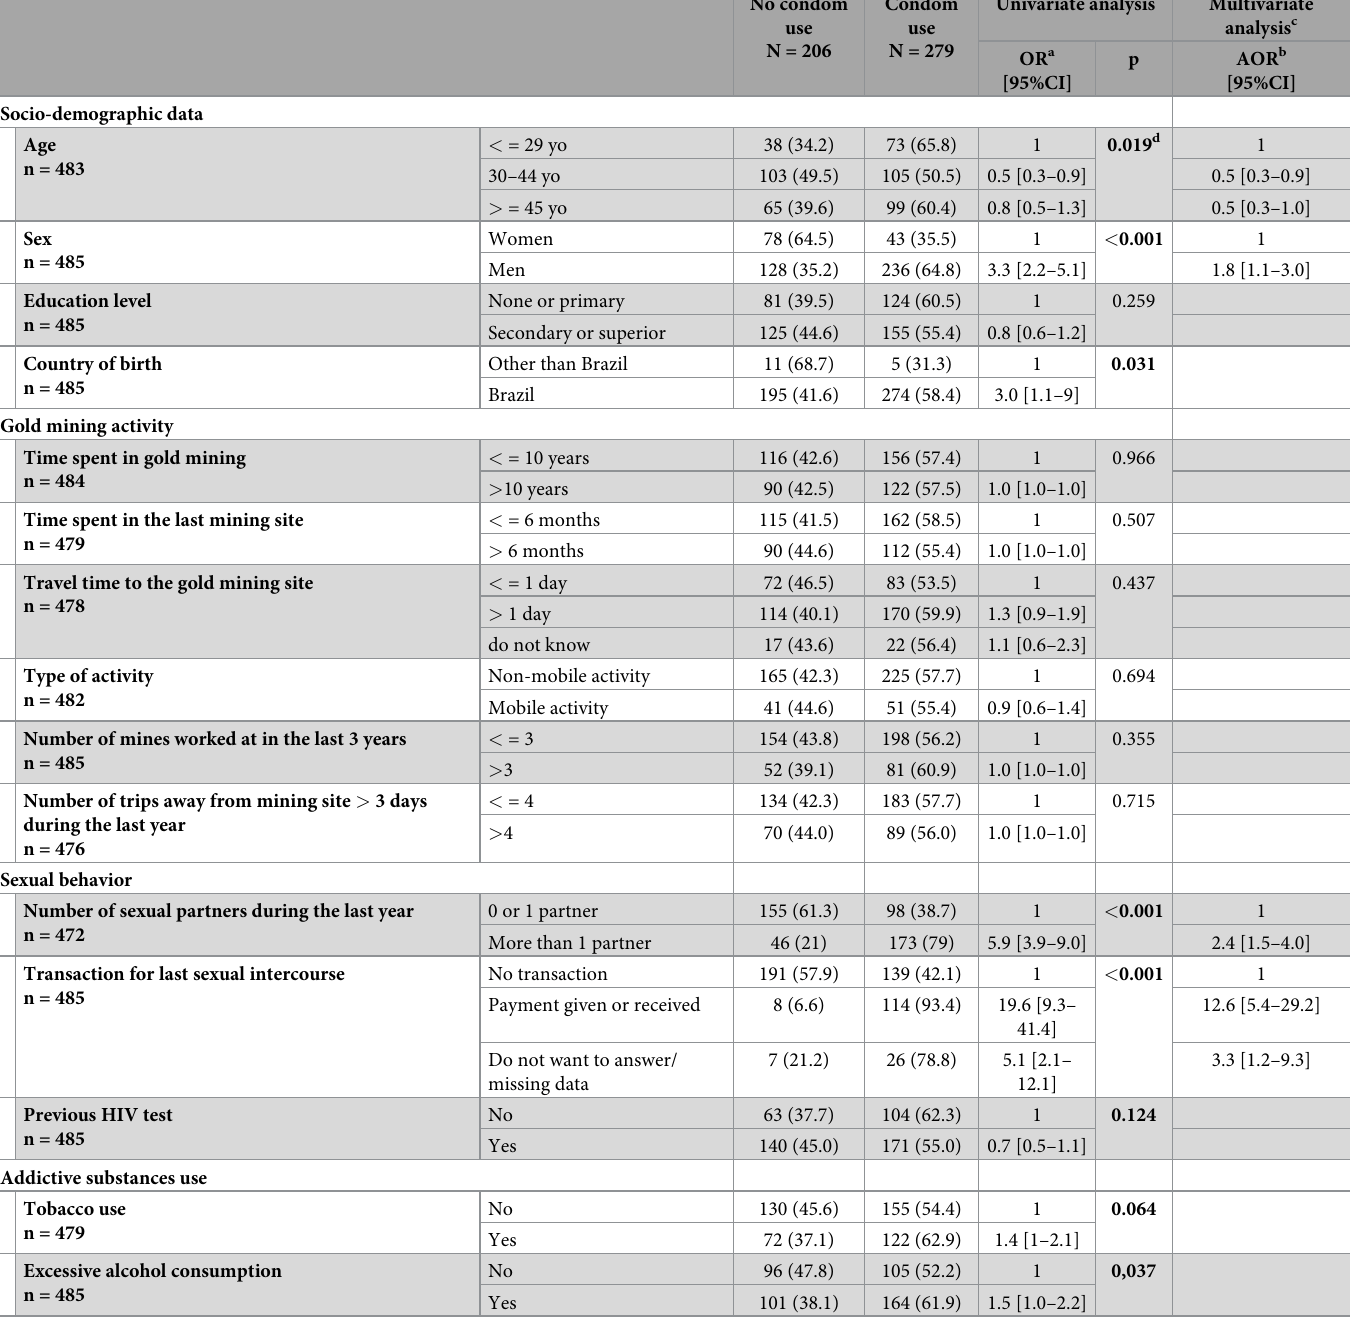
Table 3. Factors associated with condom use during the last sexual intercourse (N =